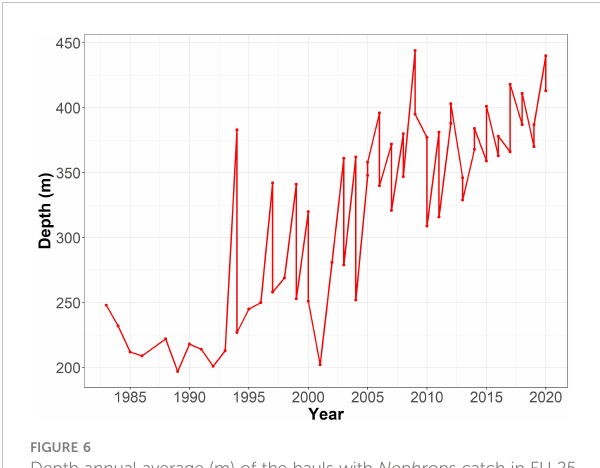
FIGURE 6 Depth annual average (m) of the hauls with Nephrops catch in FU 25 (North Galicia), FU 26-27 (West Galicia and North Portugal) and FU 31 (Cantabrian Sea), 1983-2020 (source: DCF Bottom Trawl Survey series SP-NSGFS-Q4 1983-2020 and observers onboard in commercial vessels